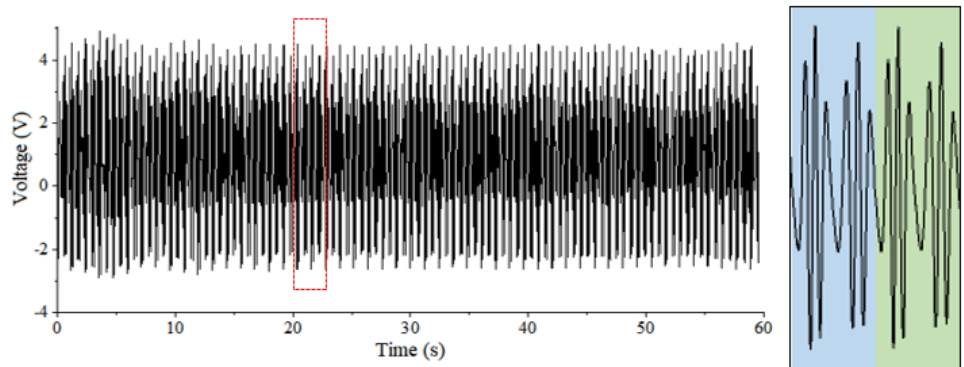
Figure 13. Voltage diagram (including the zoom-up of the enclosed region between 20.1 s and 22.5 s) under fully standing waves of T / T p = 1.0, h = 0.6 m.